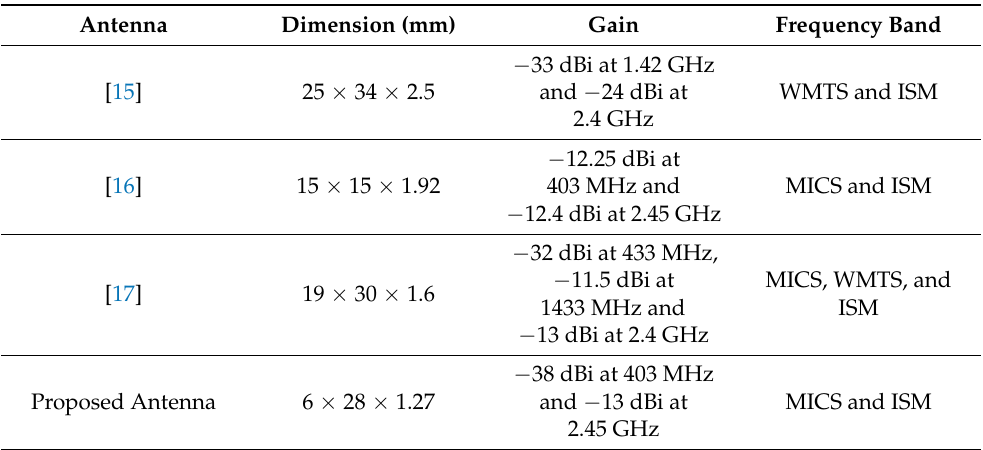
Table 1. Comparison of existing multiband antenna schemes for medical-related applications and the scheme proposed in the present article.